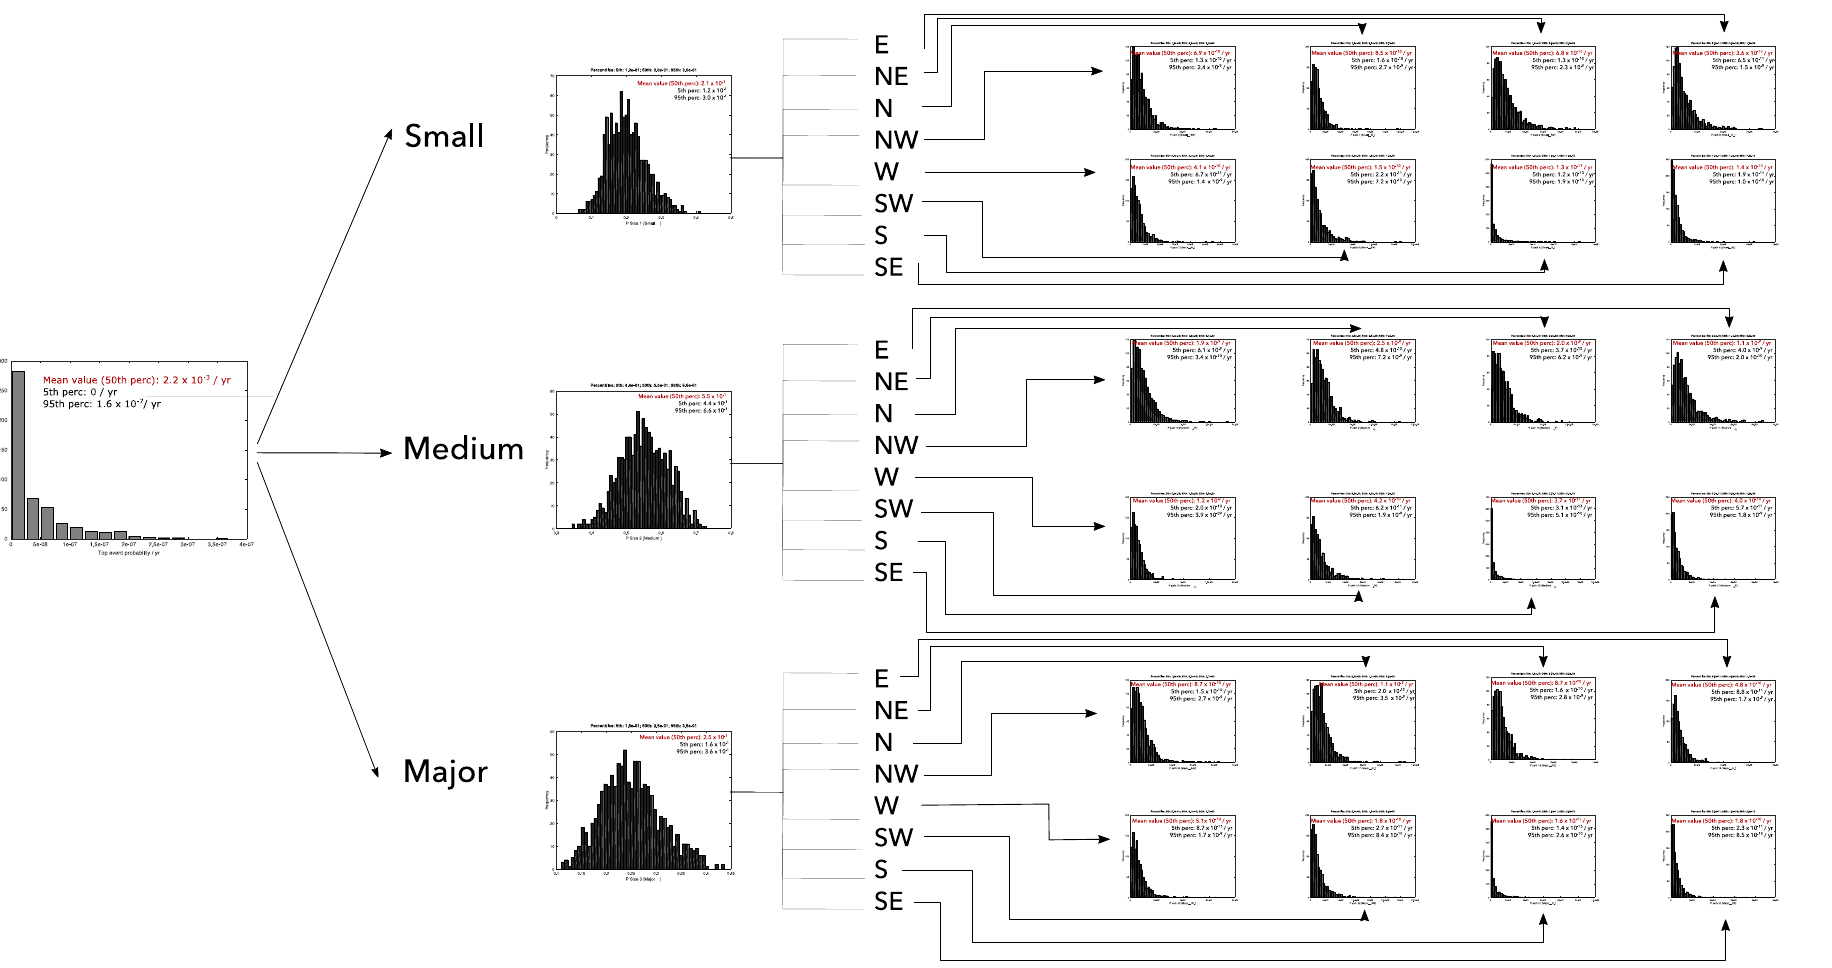
Figure 18. Sampling distribution at each node of event tree and calculation of the probability for each path.